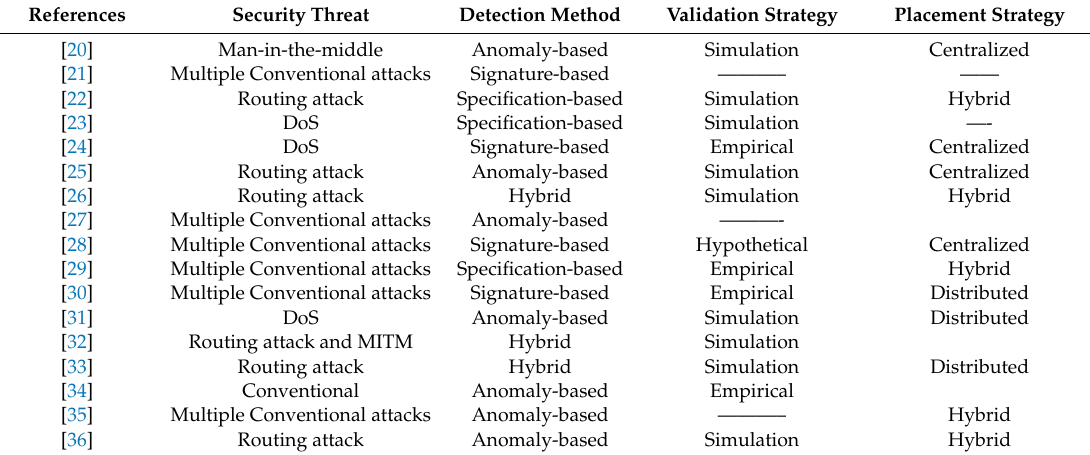
Table 1. Intrusion Detection System (IDS) for the Internet of Things